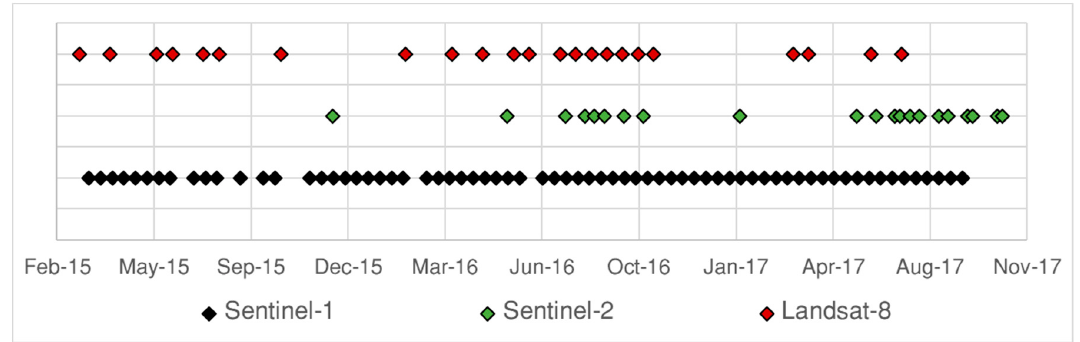
Figure 3. Overview of the temporal data coverage of 69 Sentinel-1A, 21 Sentinel-2A/-2B, and 23 Landsat-8 satellite scenes.